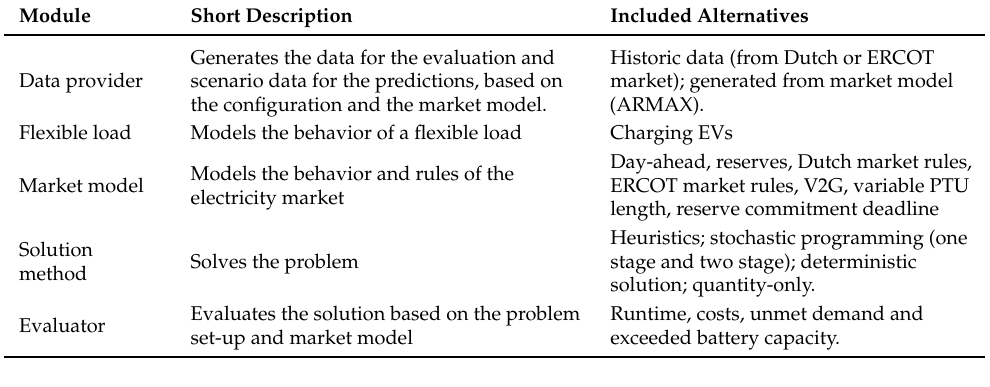
Table 1. An overview of the modules of B-FELSA and the included alternatives/parameters which can currently be used.